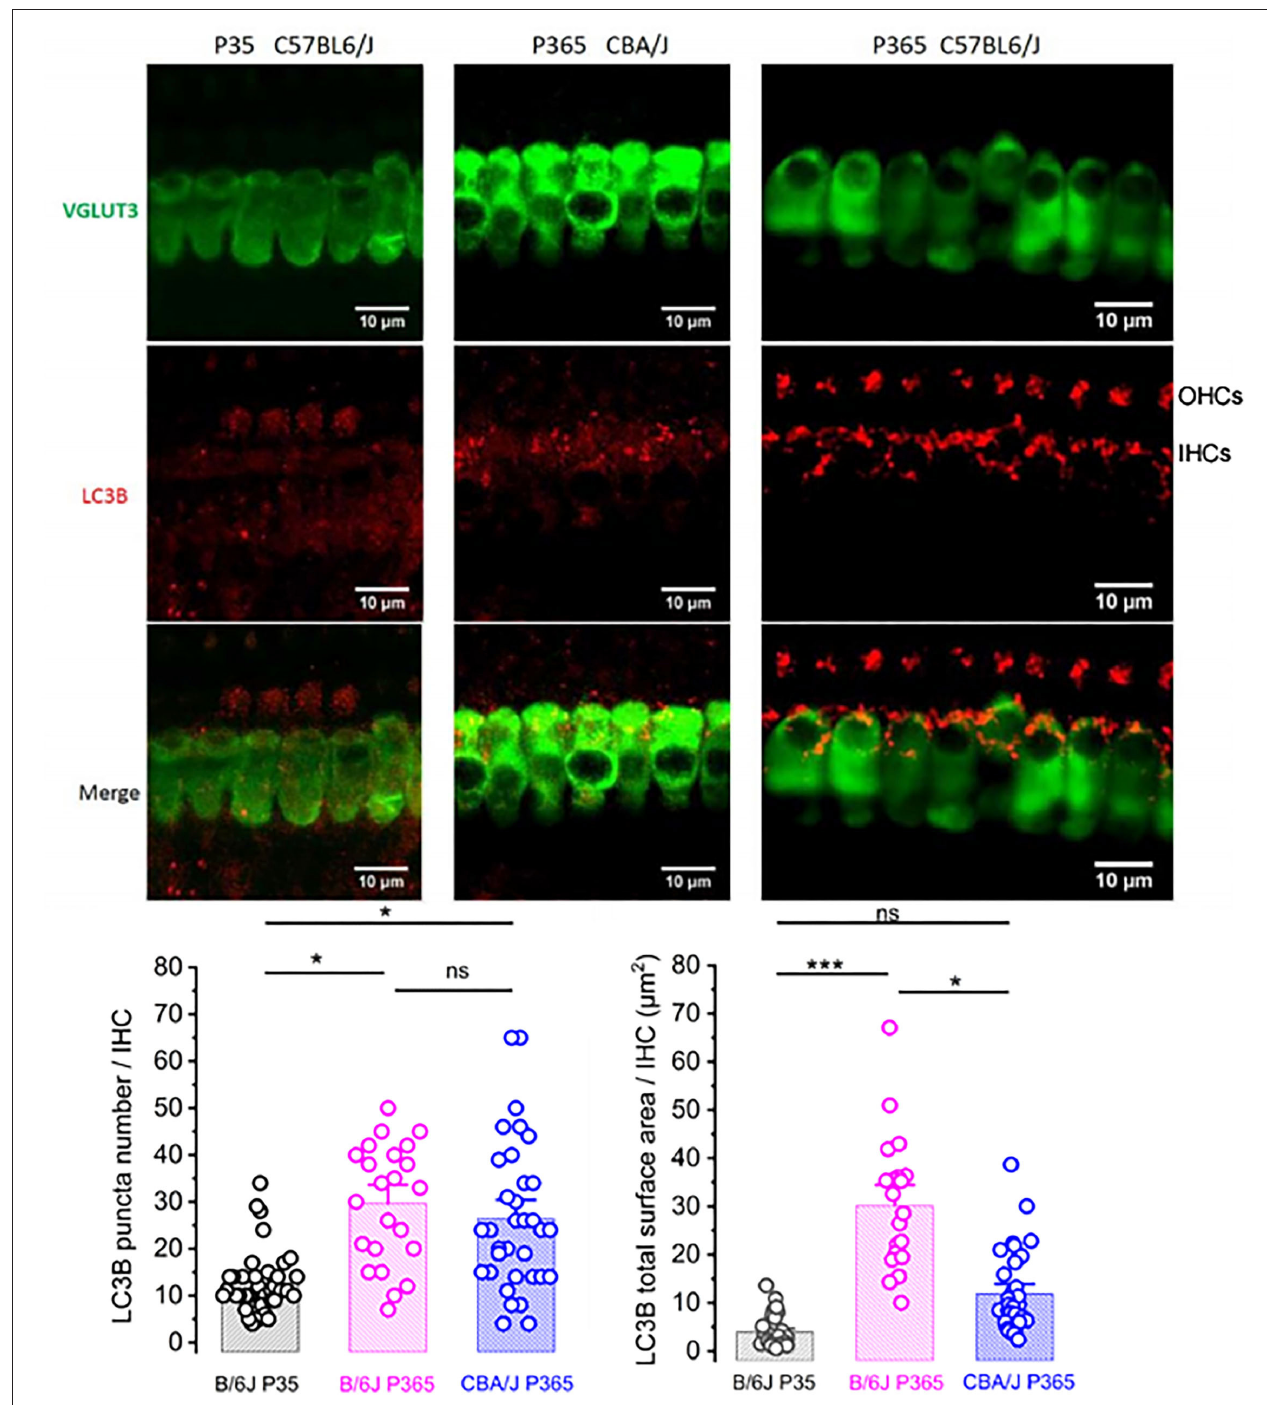
FIGURE 9 | LC3-positive structures are prominent in aging IHCs. Representative confocal immunofluorescence images showing LC3B staining in IHCs from young P30 C57BL/6J (left), old P365 CBA/J (middle), and old P365 C57BL/6J (right) mice. The histograms below show the quantification of the LC3B puncta average number and average mean surface area per IHC. Images were obtained from processing confocal stack images (22 of 0.3 µ m thickness) using ImageJ quantification tool (3D-object counter). Quantification was performed from 23 to 38 IHCs for each condition in the mid-cochlea (encoding region 8–16kHz; 3 mice). Asterisks indicate statistical significance p < 0.05 (unpaired t